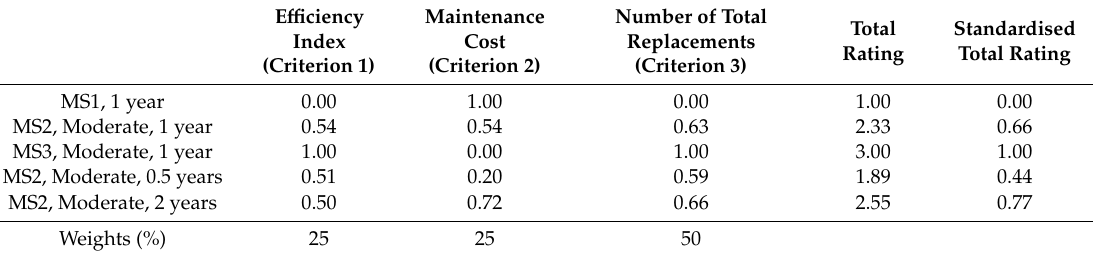
Table 12. Scenario 4: the higher weight of the number of total